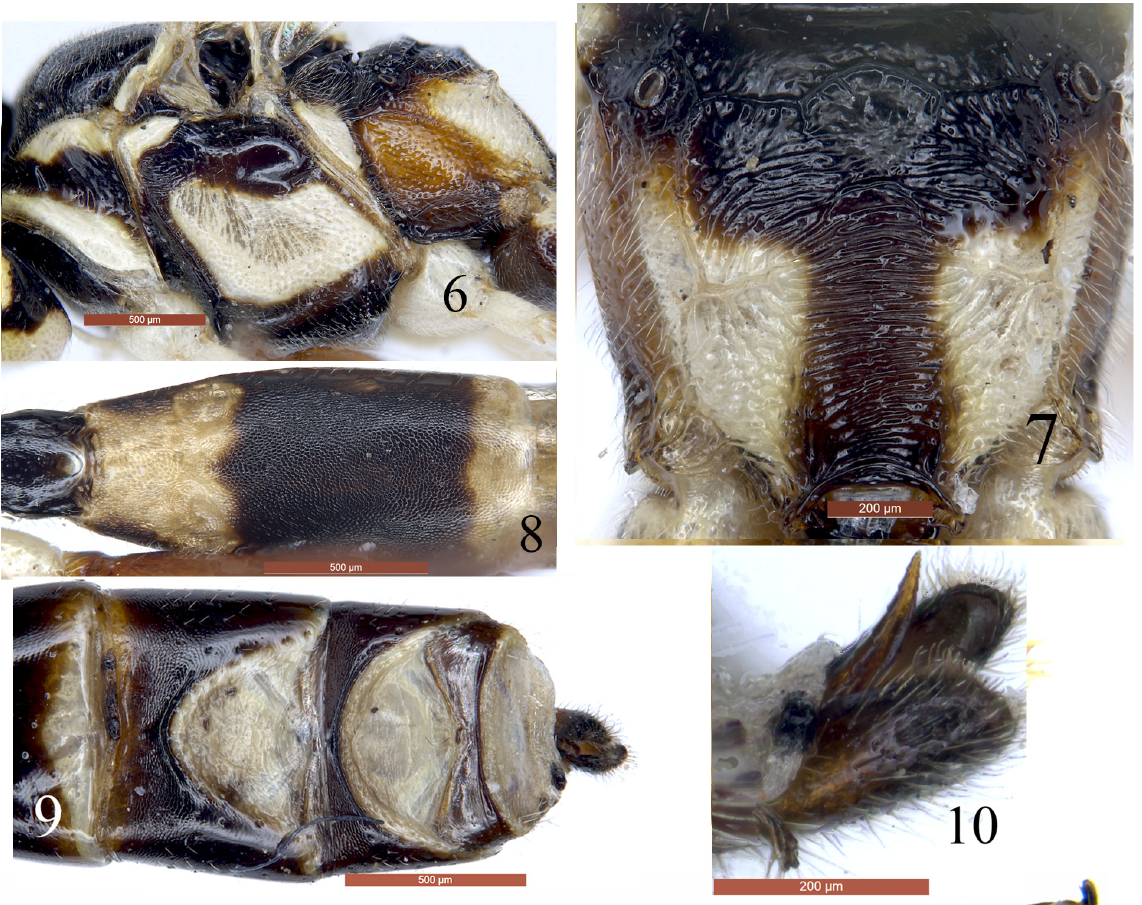
Figs 6–10. Notosemus albimaculatus Sheng & Sun, sp. nov., holotype. 6 . Mesosoma, lateral view. 7 . Propodeum. 8 . Postpetiole and tergite 2, dorsal view. 9 . apical portion of metasoma, dorsal view. 10 .